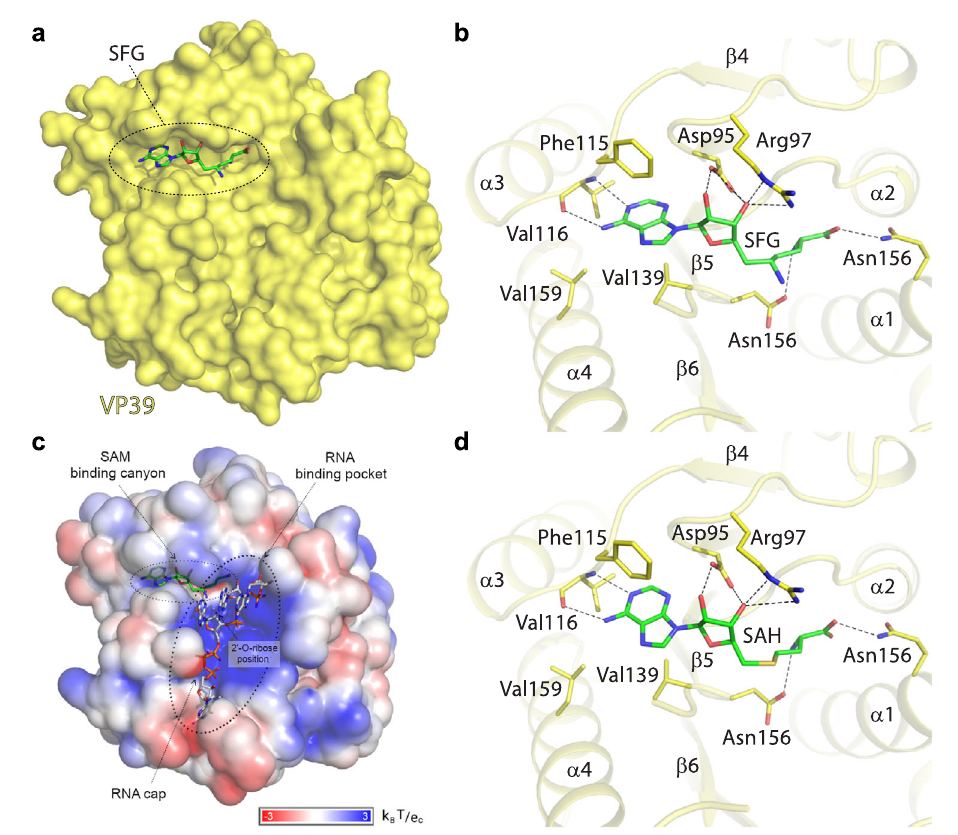
Fig. 2 | Sinefungin and SAH recognition by the monkeypox virus VP39 methyltransferase.a SinefunginisboundintheSAMbindingsite.VP39isshownin surface representation. b Detailed view of sinefungin or d SAH in the binding site. Sinefungin,SAHandsidechainsofselectedVP39aminoacidresiduesareshownin thestickrepresentationwithcarbonatomscoloredaccordingtotheprotein/ligand assignment and other elements colored as usual. Selected hydrogen bonds involved in the VP39-sinefungin interaction are presented as dashed black lines.